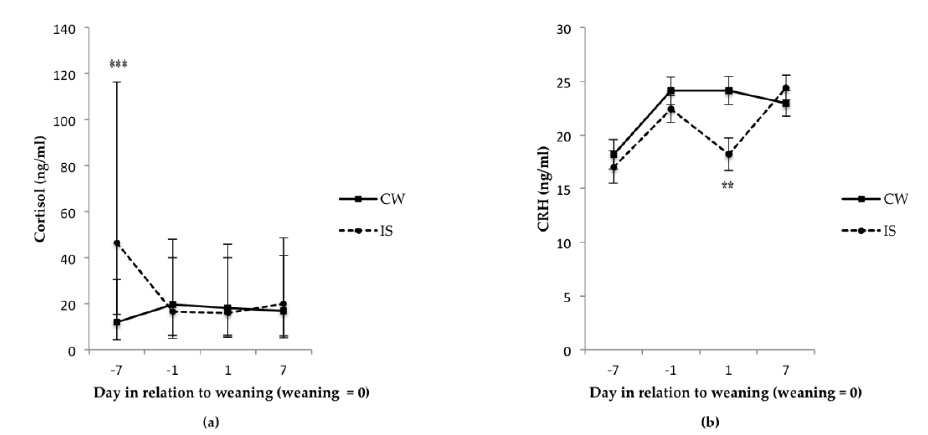
Figure 1. Effect of intermittent suckling (IS) on plasma ( a ) cortisol and ( b ) corticotropin releasing hormone (CRH) of piglets before and after weaning. ** Indicates differences between treatments ( p < 0.01) per sampling day; *** indicates differences between treatments ( p < 0.001); n = 20 for conventional weaning (CW) and n = 22 for IS. Plasma cortisol data were logarithmically transformed and then back transformed and expressed as least square means with 95% confidence intervals.